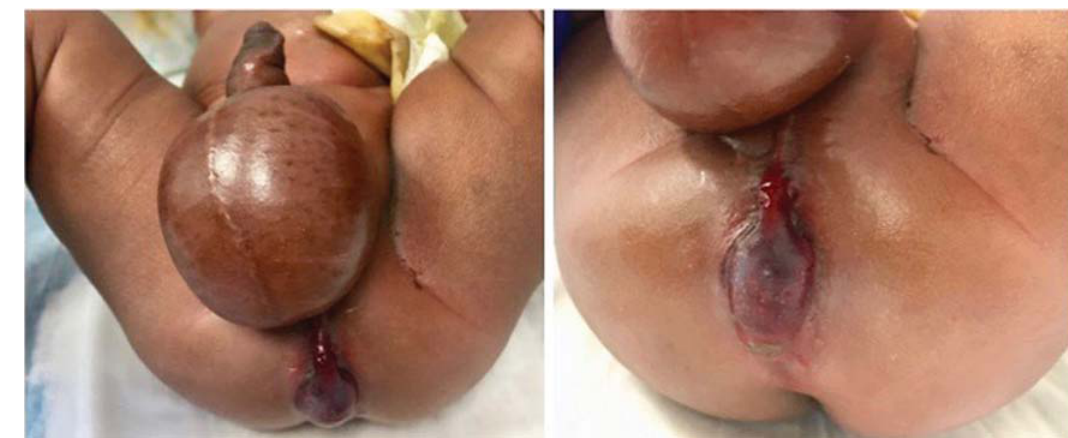
Fig. 4 Case 2. Features of the perineum and scrotum immediately after the perforation occurred.